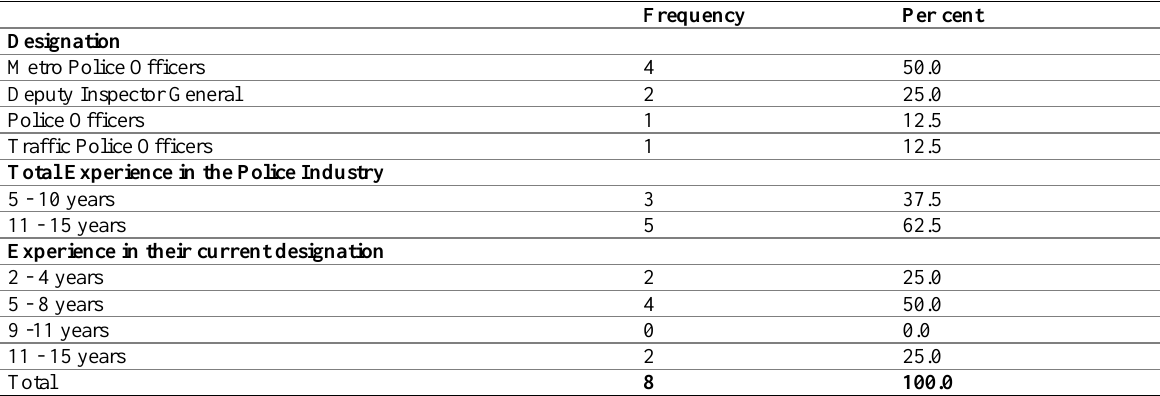
Table 5: Demographic Profile of Male police